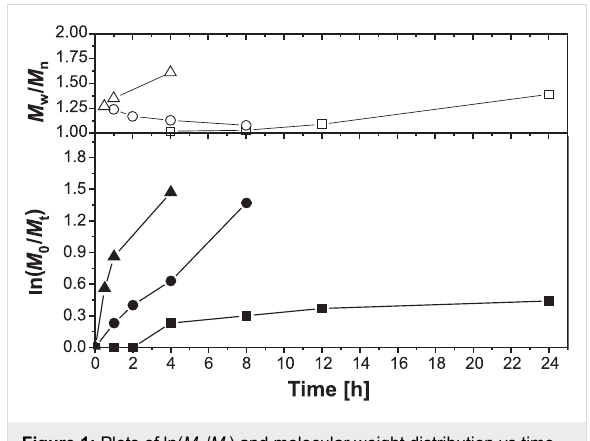
Figure 1: Plots of ln( M 0 / M t ) and molecular weight distribution vs time of the homopolymerization of 2VP at ■ 90 °C, ● 110 °C, ▲ 130 °C (molar ratio [initiator]/[monomer]